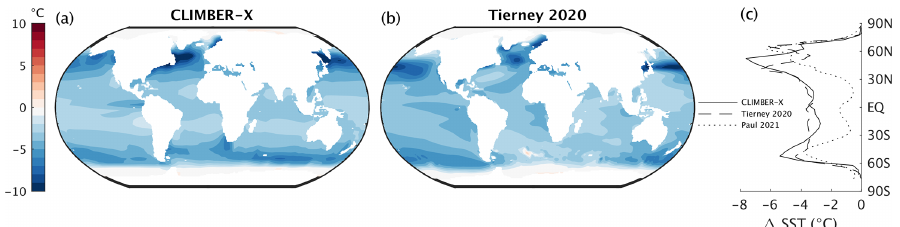
Figure 29. Last glacial maximum annual mean sea surface temperature differences relative to pre-industrial compared to reconstructions (Paul et al., 2021; Tierney et al., 2020).